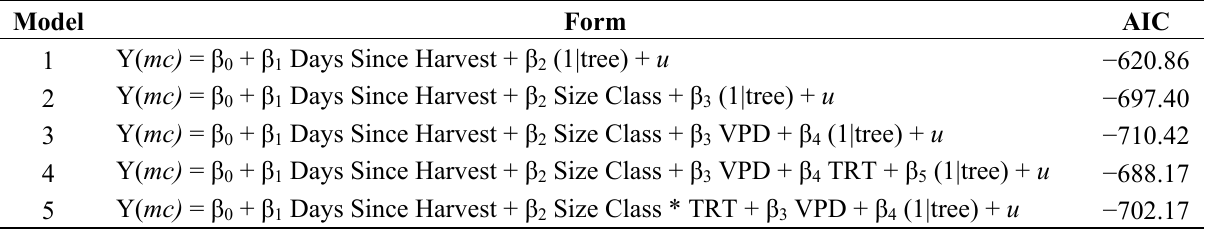
Table 5. The results of Akaike’s Information Criterion (AIC) testing to determine the significant model variables.